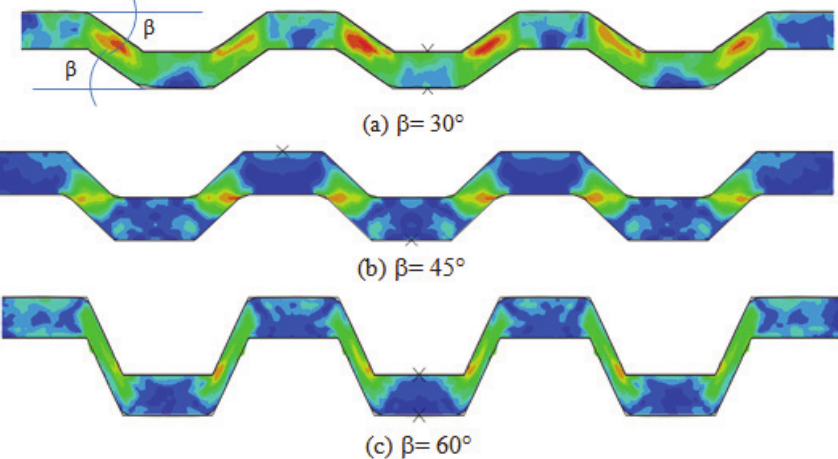
Figure 12: Illustration of the different values of the angle β of the tool